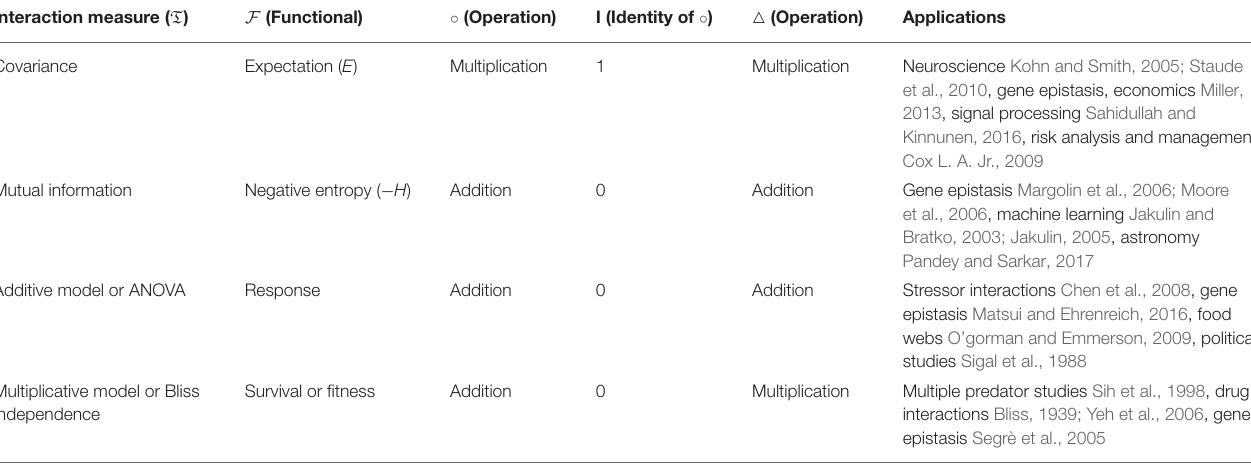
TABLE 1 | Summary table of two-way interaction measures with our generalized formula T XY = F ( X ◦ Y ) − ( F ( X ◦ I ) △ F ( Y ◦ I )) . Interaction measure ( T